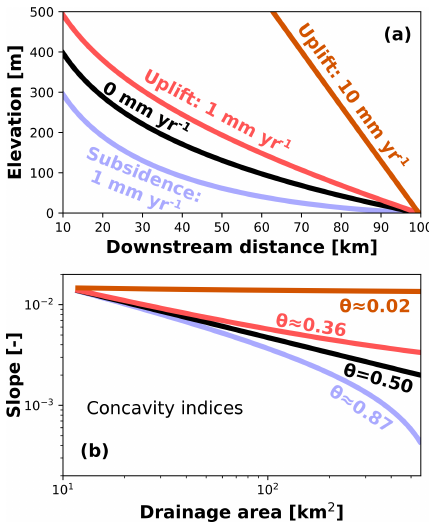
Figure 3. Steady-state numerical model outputs with steady up- lift (base-level fall), subsidence (base-level rise), or neither. These numerical solutions are formulated following Eq. (D3), which is a finite-difference discretization of the general equation for an equilibrium-width transport-limited gravel-bed river, Eq. (20). Power-law relationships describe downstream increases in water discharge ( Q ) and valley width ( B ), following Eqs. (31)–(36). (a) Long profiles. All channels are plotted such that they are pinned to the same downstream point. (b) Slope–area plots: concavities in- crease with increasing subsidence. Model input parameters other than uplift are the same as those given for the long profiles dis- played in Fig.